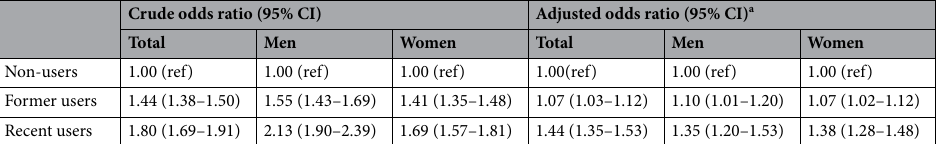
The association between the use of antidepressant drugs and the risk of subsequent low bone density is shown in Table 2. The odds ratio (OR) was 1.44 (95% CI 1.38, 1.50) for former users and 1.80 (95% CI 1.69, 1.91) for recent users. Use of SRIs remained an independent predictor of subsequent low bone density after adjusting for potential confounders (glucocorticoids, aromatase inhibitors, androgen deprivation therapy, GnRH agonists, anticonvulsants, thiazolidinediones, DMPA, antipsychotics, benzodiazepine, TCA, Estrogen or Estrogen and progesterone combination, household income, CCI, BMI, systolic and diastolic blood pressures, fasting blood glucose level, total cholesterol level, hemoglobin level, urine occult blood, urine protein, AST, ALT, smoking status, frequency of drinking alcohol, and frequency of exercise). After adjusting for those potential confound- ers, former use of SRIs was associated with a 1.07-fold higher risk of low bone density than was found among